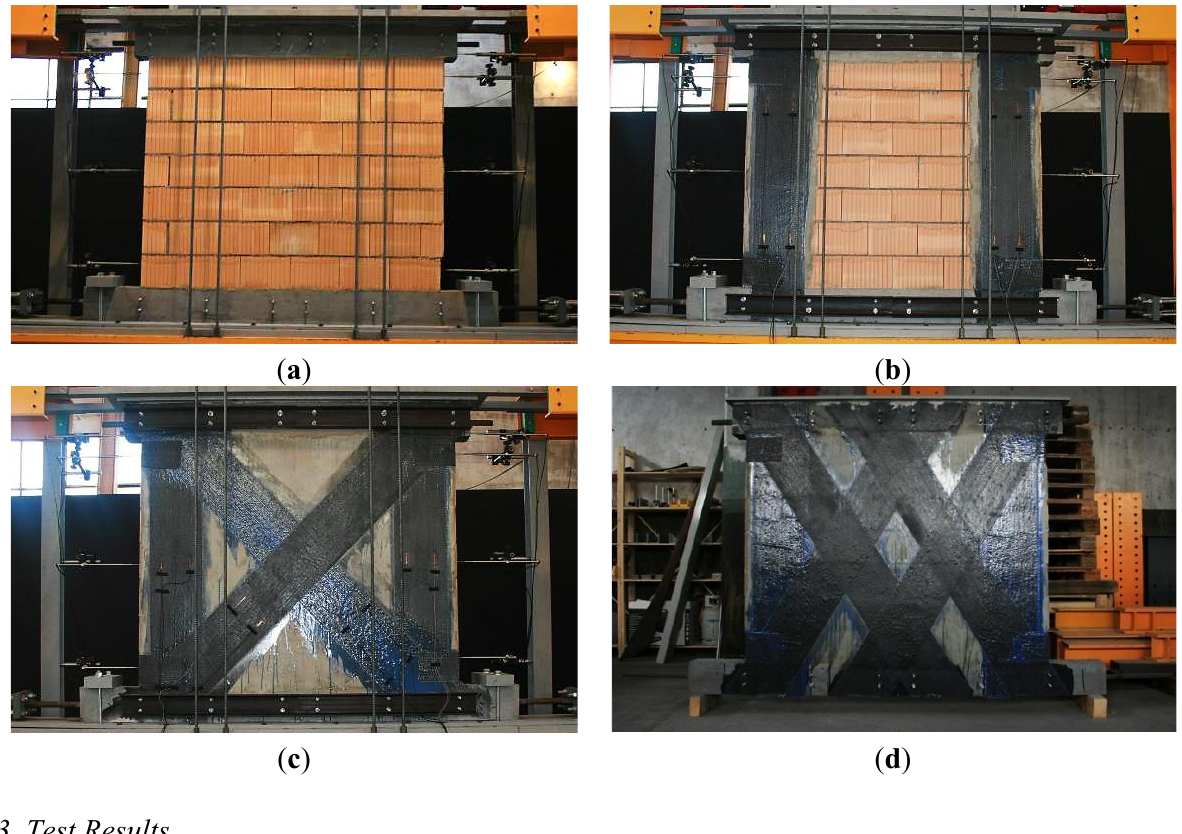
Figure 2. Different configurations of carbon mesh for retrofitting masonry walls in Series